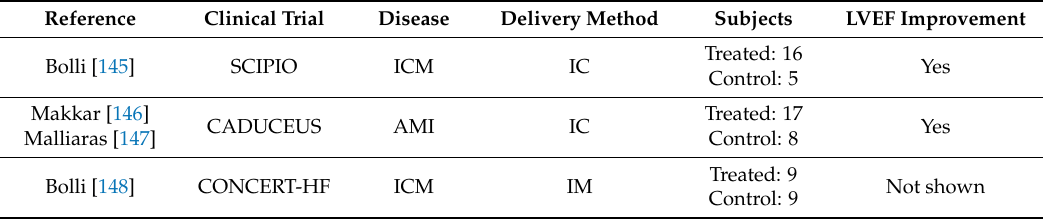
Table 9. Clinical trials with CSCs for cardiac